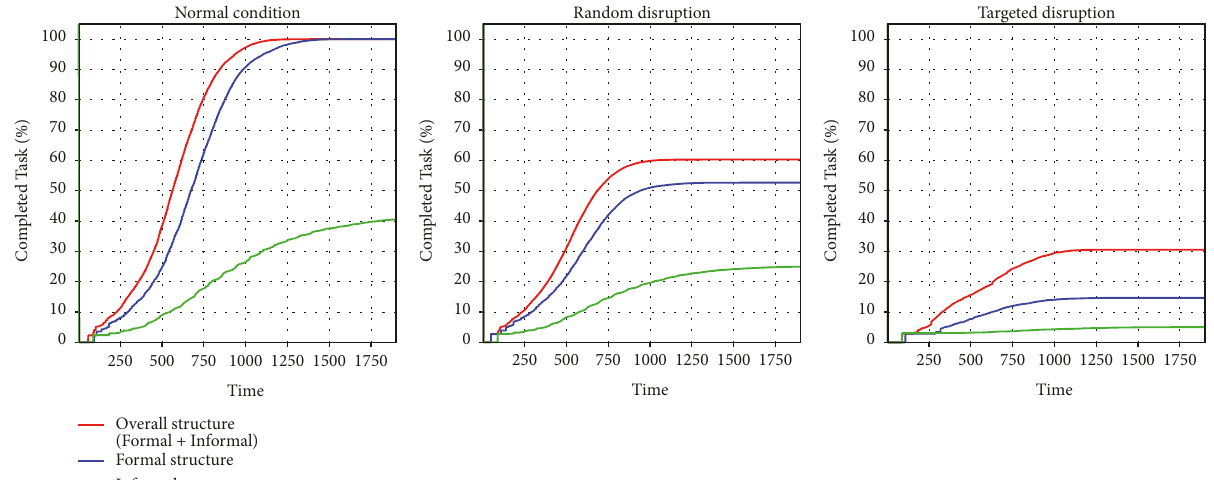
Figure 4: Performance of organisational structures in normal and disrupted conditions.